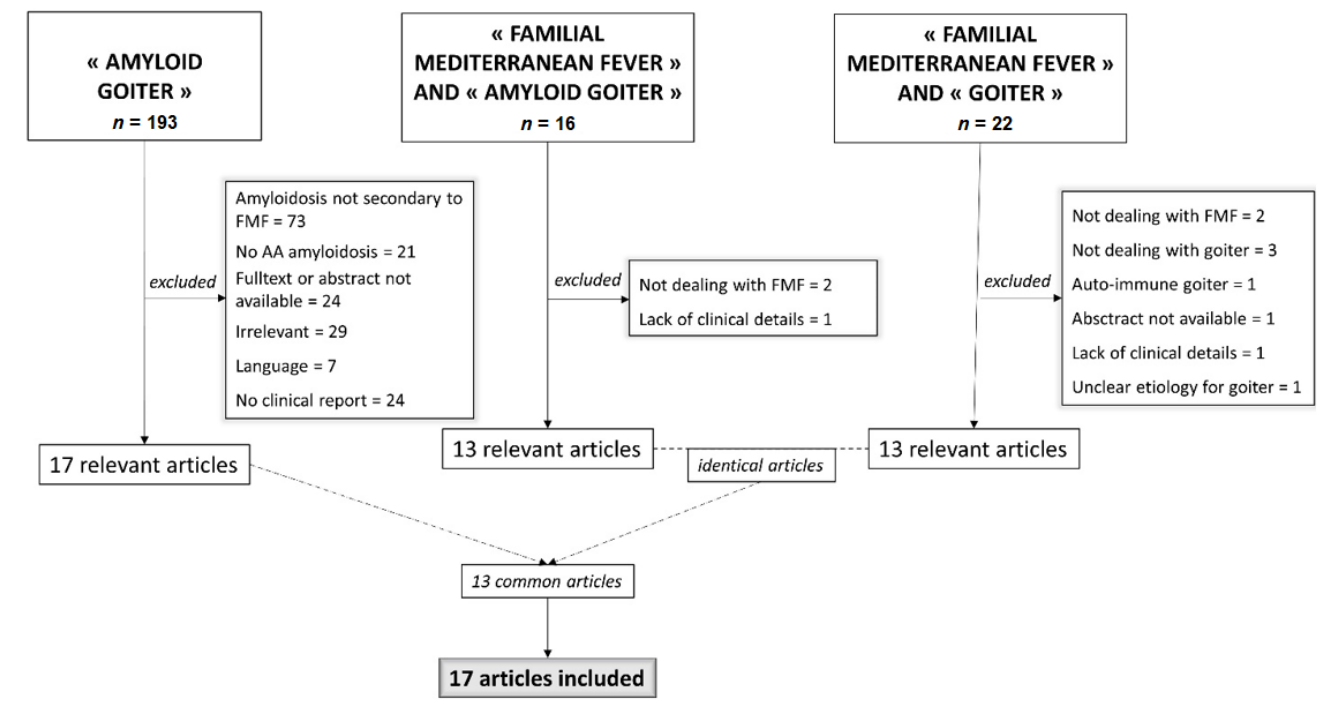
Figure 1. Flowchart. Figure 1.